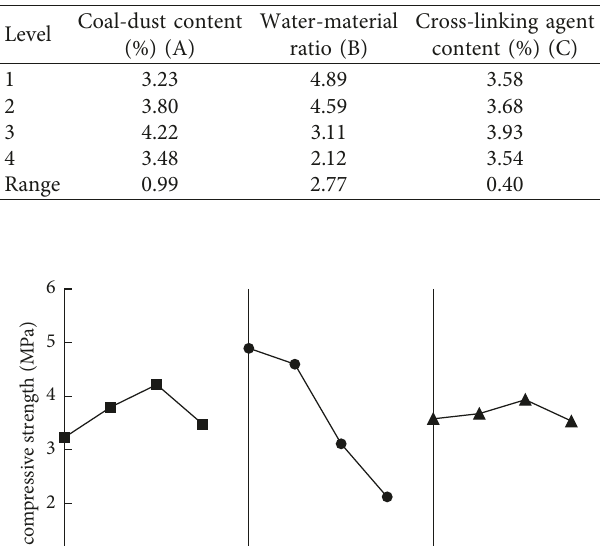
Table 5: Range analysis of the influencing factors of 3-d com- pressive strength.